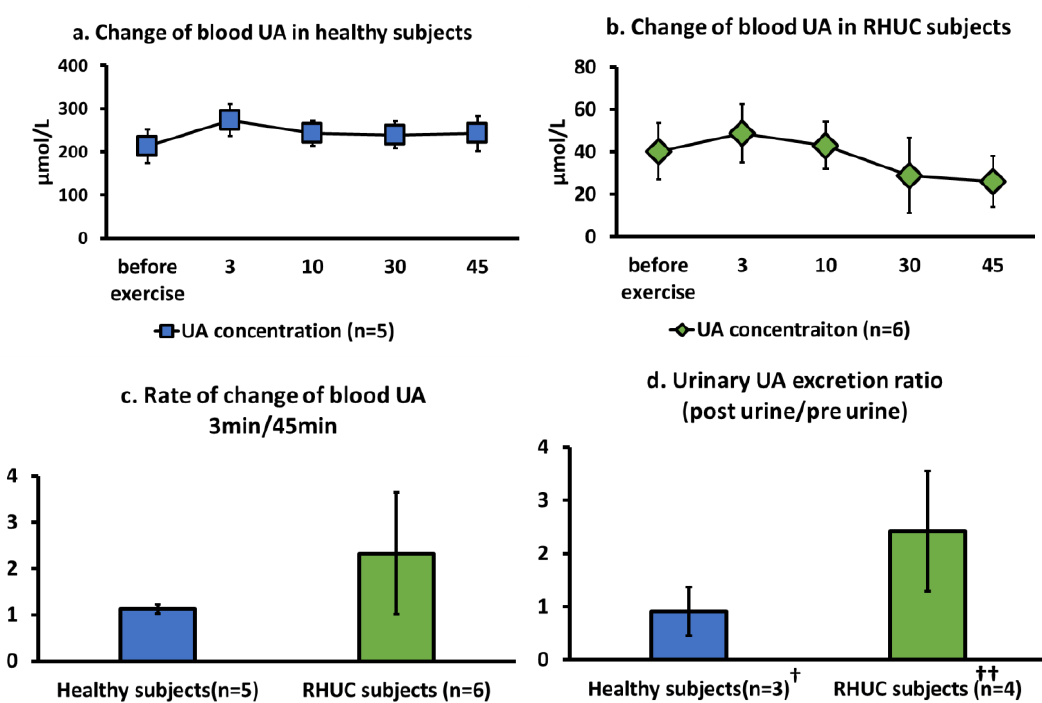
Figure 3. Change of blood UA concentration following semi-ischemic forearm exercise test. ( a , b ): Changes of blood UA concentration over time in five healthy subjects and six RHUC subjects. ( c ): The ratio of blood UA concentration at 3 min of maximum value to blood UA concentration at 45 min at the end of exercise load, representing the rate of change of blood UA concentration after exercise load. ( d ): The ratio of urinary UA excretion after exercise to urinary UA excretion per minute before exercise in three healthy subjects and four RHUC subjects, representing the rate of change in urinary UA excretion after exercise. † The three healthy subjects in ( d ) are samples from healthy subject 3, a 24-year-old healthy male, and a 35-year-old healthy man who consented to the study. †† The four RHUC subjects in ( d ) are RHUC 1, 2, 5, and 6. UA, uric acid; RHUC, renal hypouricemia.